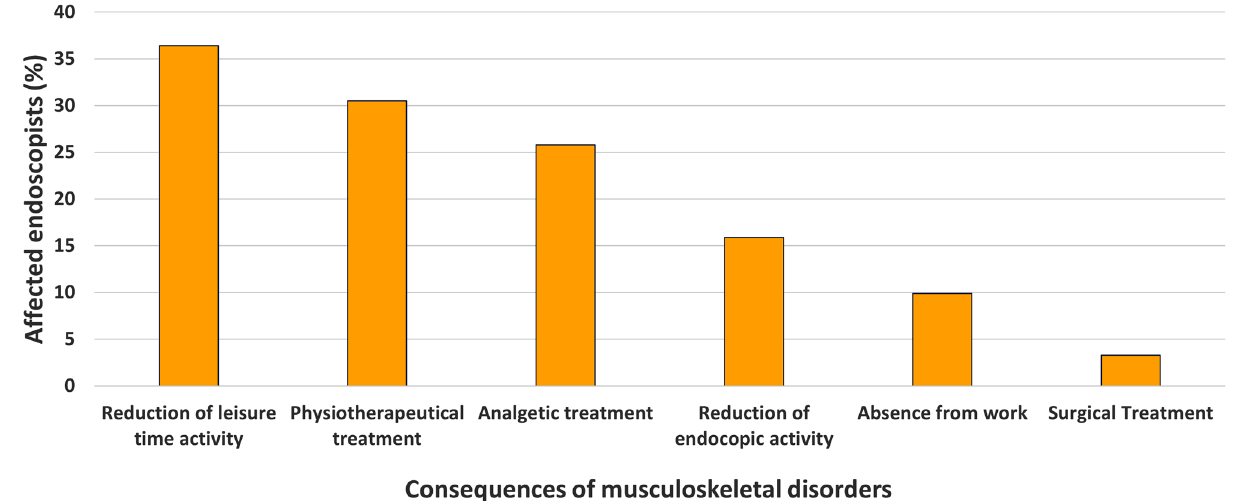
Figure 3. Consequences of musculoskeletal health disorder in German endoscopists (%).